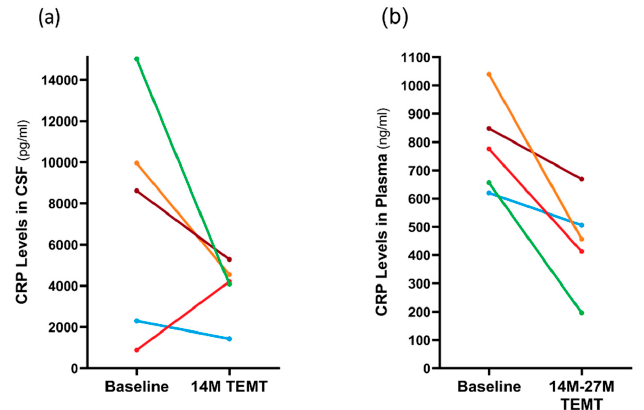
Figure 8. For individual subjects, effects of 14 M TEMT on C-reactive protein (CRP) levels in CSF ( a ) and effects of 14–27 M of TEMT on plasma CRP levels ( b ). Each color depicts the same subject. As was the case for the CRP levels in CSF, the p-tau217 levels in CSF were also re-